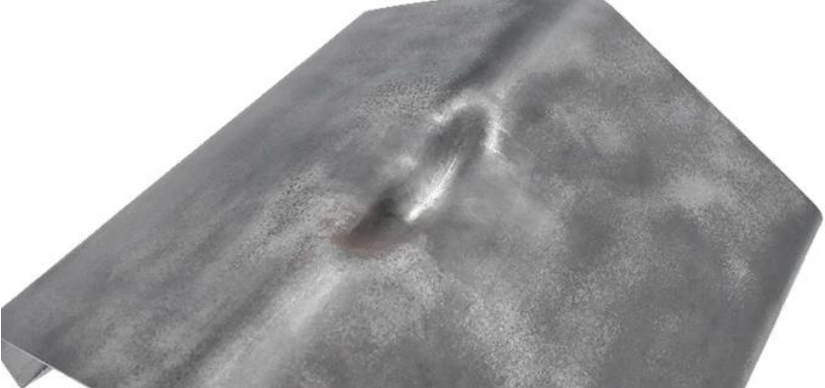
Figure 5. Photograph showing permanent damage in the central region of a blast-tested 120° V- structure (32 mm tip radius, tested at 20 g).